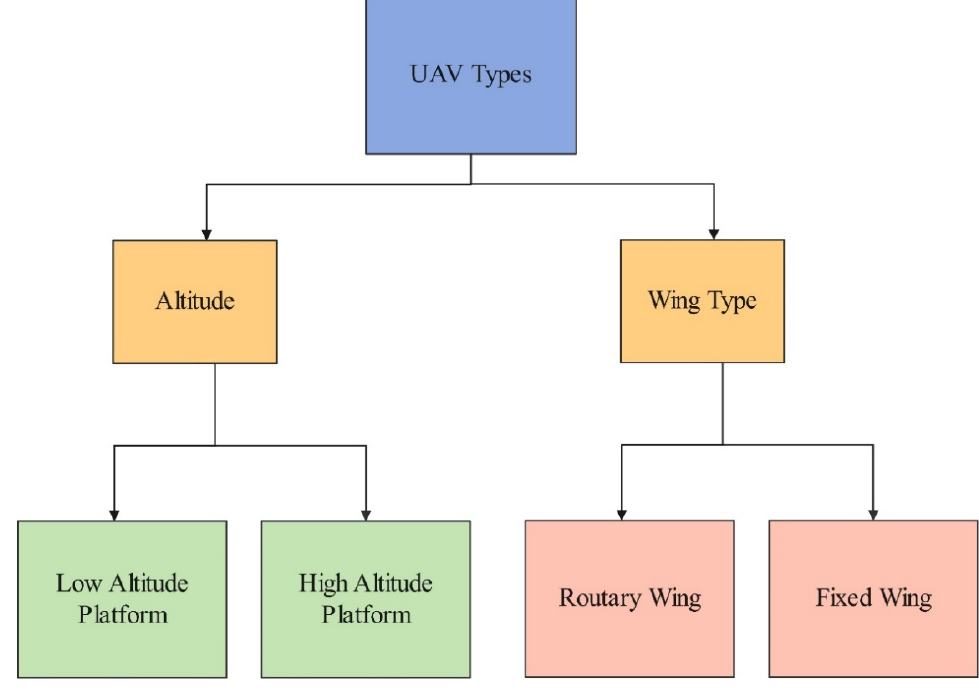
Figure 14. Classification of UAV.